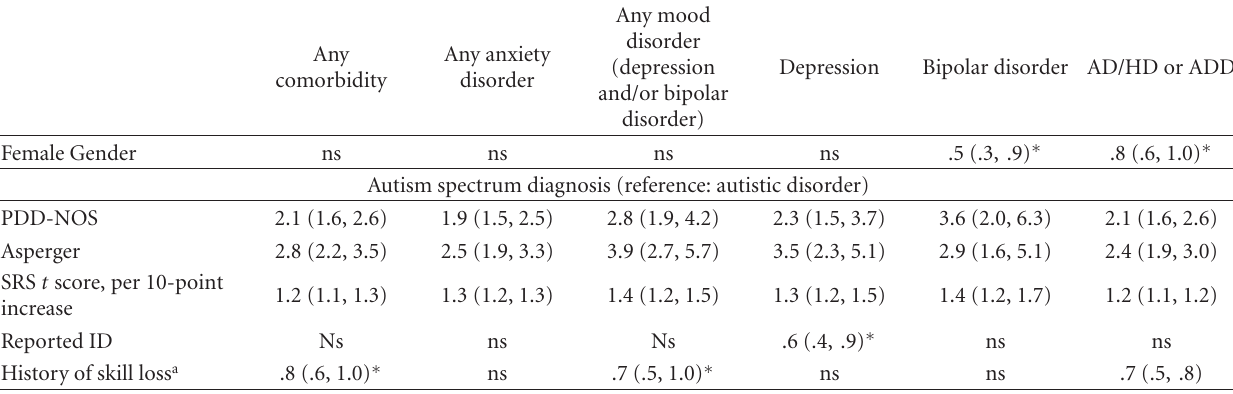
Table 4: Multivariate logistic regression odds ratios (95% CI) of overall and individual parent-reported lifetime psychiatric comorbidities in ASD ( n = 2219), by statistically significant factor ( P < . 001 unless otherwise